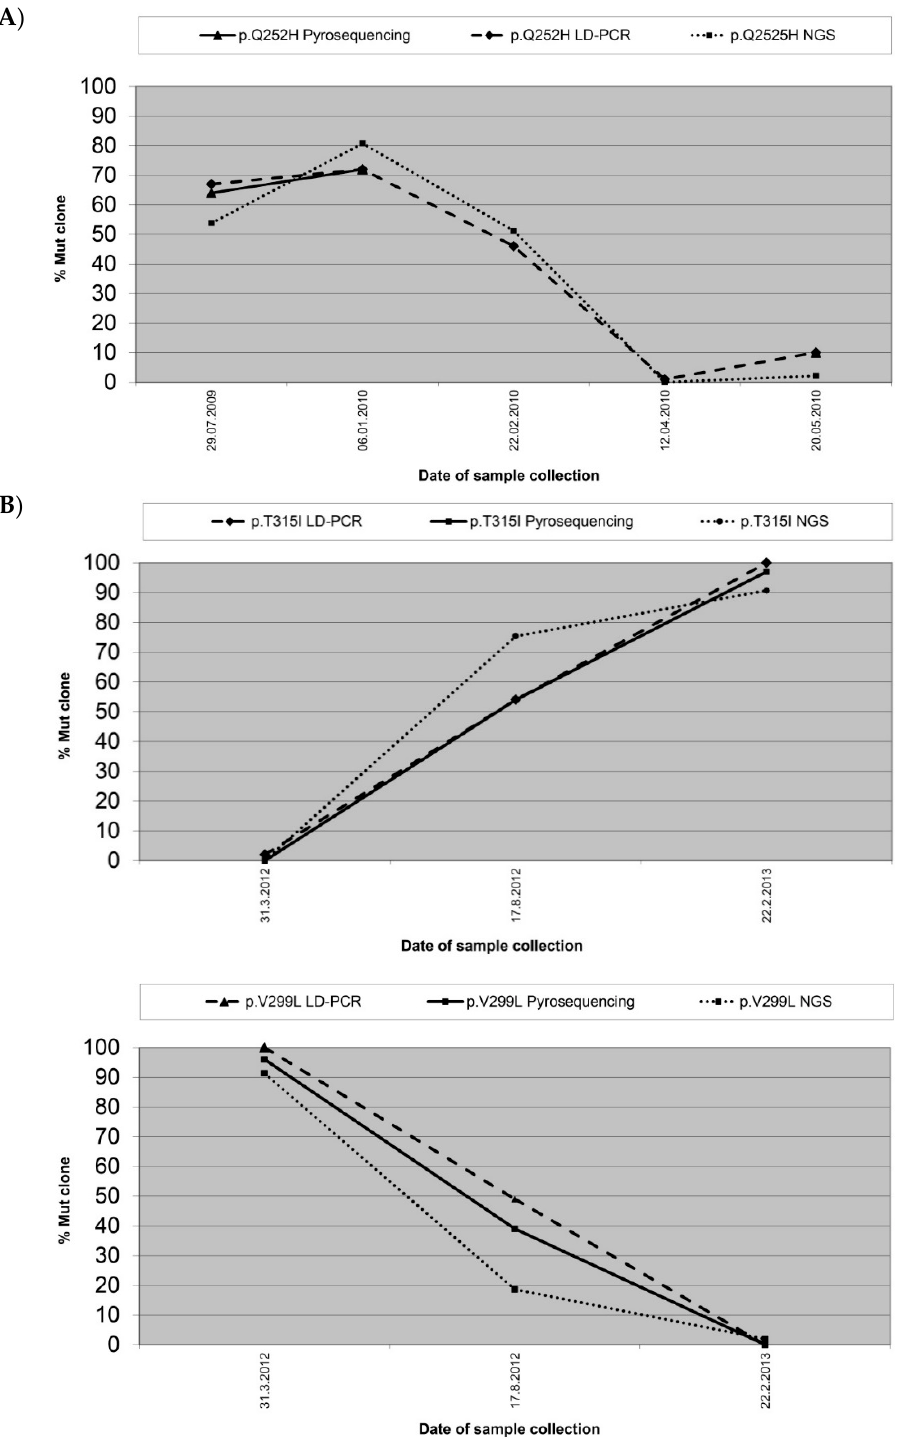
Figure 3. Comparison of mutant subclone monitoring by different methods. Serial specimens from CML patients carrying ( A ) a single mutation, p.Q252H (c.756G>T) or ( B ) two independent mutations, p.T315I ( upper panel) and p.V299L (c.895 G>T) ( lower panel), are displayed showing the monitoring by LD-PCR (dashed line), pyrosequencing (solid line), and NGS on the FLX+ Roche platform (dotted line). The concordant kinetics, as determined by all technical approaches employed, are highlighted particularly by the largely overlapping curves of analyses by LD-PCR and pyrosequencing.